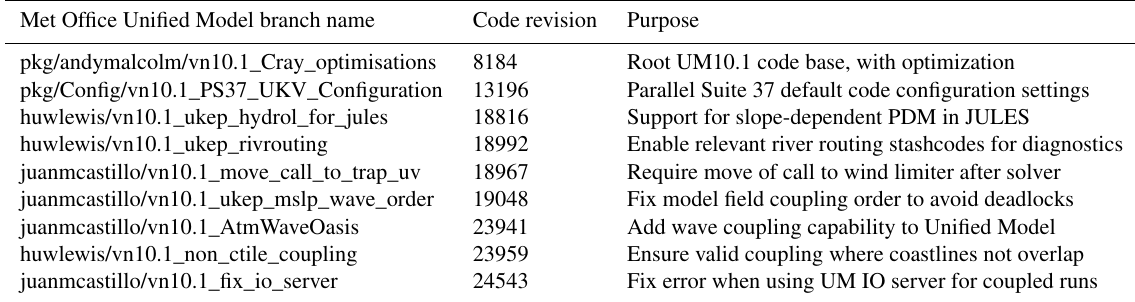
Table C1. Summary of Met Office Unified Model code branches merged and used in the UKA2 and UKC2 system, containing relevant adaptations from the version 10.1 baseline code. Model code are accessible via https://code.metoffice.gov.uk/trac/um/wiki (Met Office, 2017g). Registered users can directly access each code branch at the revision used in UKC2 by following the direct code revision links provided.